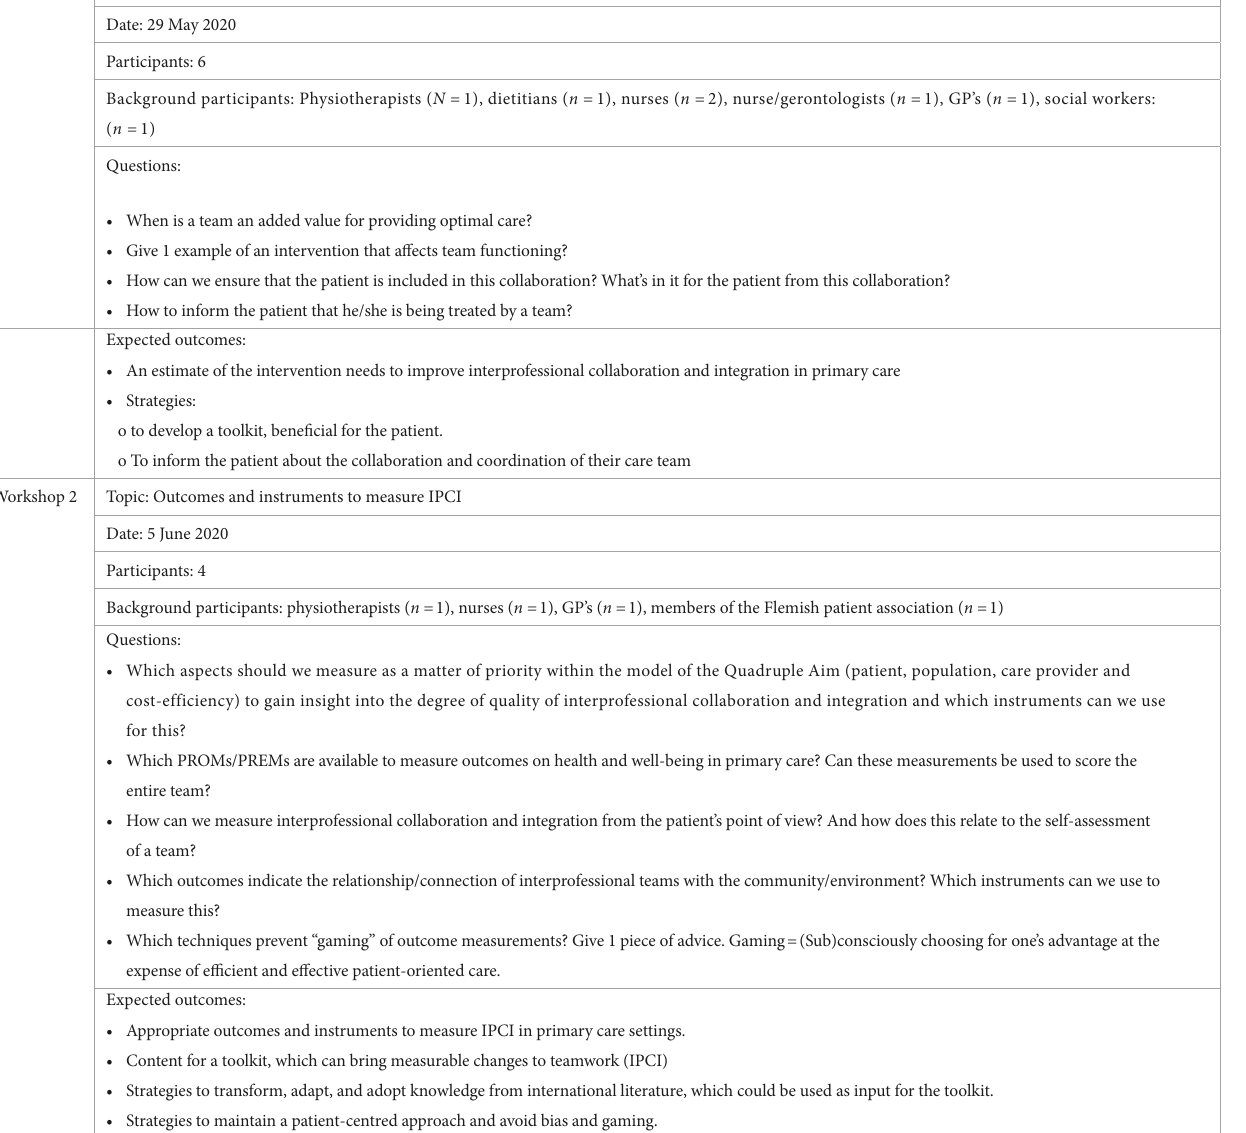
TABLE 3 Overview of the co-design workshop sessions: topic, date, number of participants, background participants, and the questions. Workshop 1 Topic: Content development IPCI-toolkit